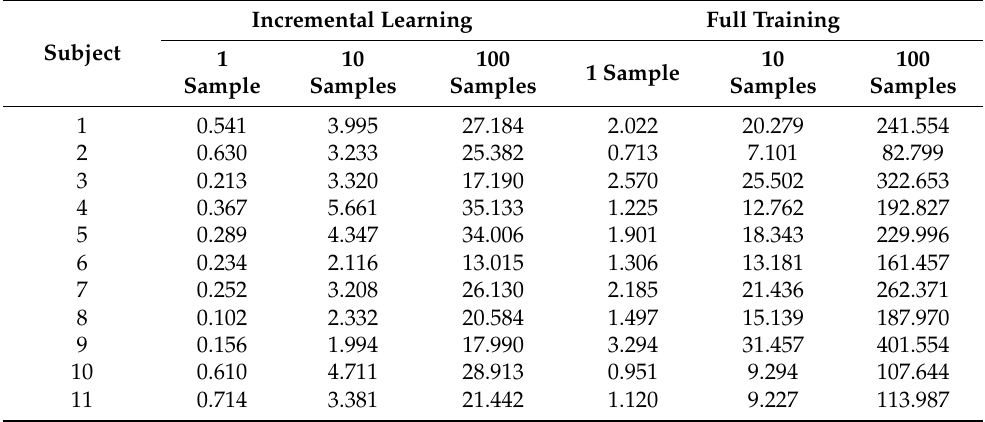
Table 3. Training time (s) using the incremental learning and full training while varying the number of arriving samples.